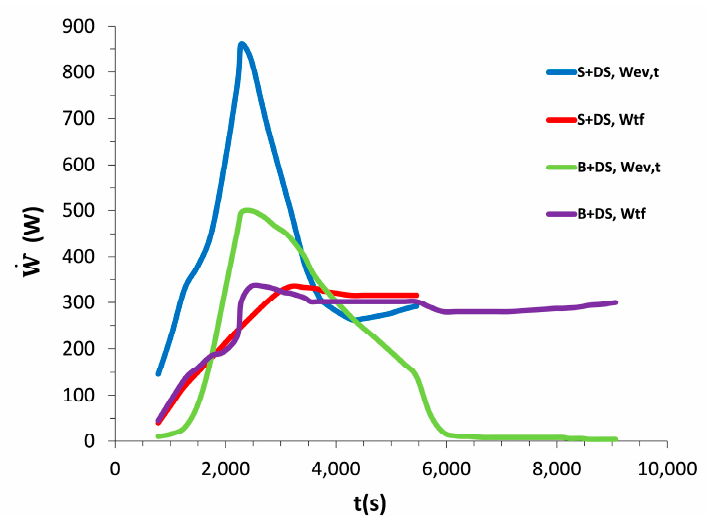
Figure 10. Power required for the evaporation of the total volume of liquid.